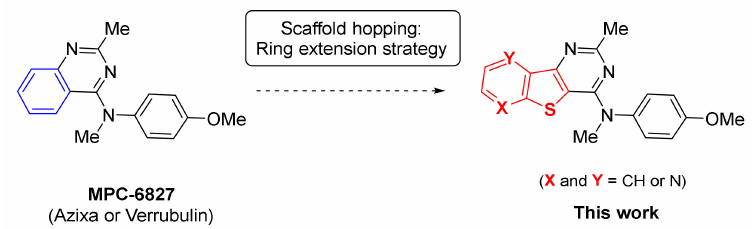
Figure 2. Structure of MPC-6827 and N -(4-methoxyphenylamino)-2-methyl benzo-, pyrido- or pyrazino-thieno[3,2- d ]pyrimidine derivatives envisioned in this work.